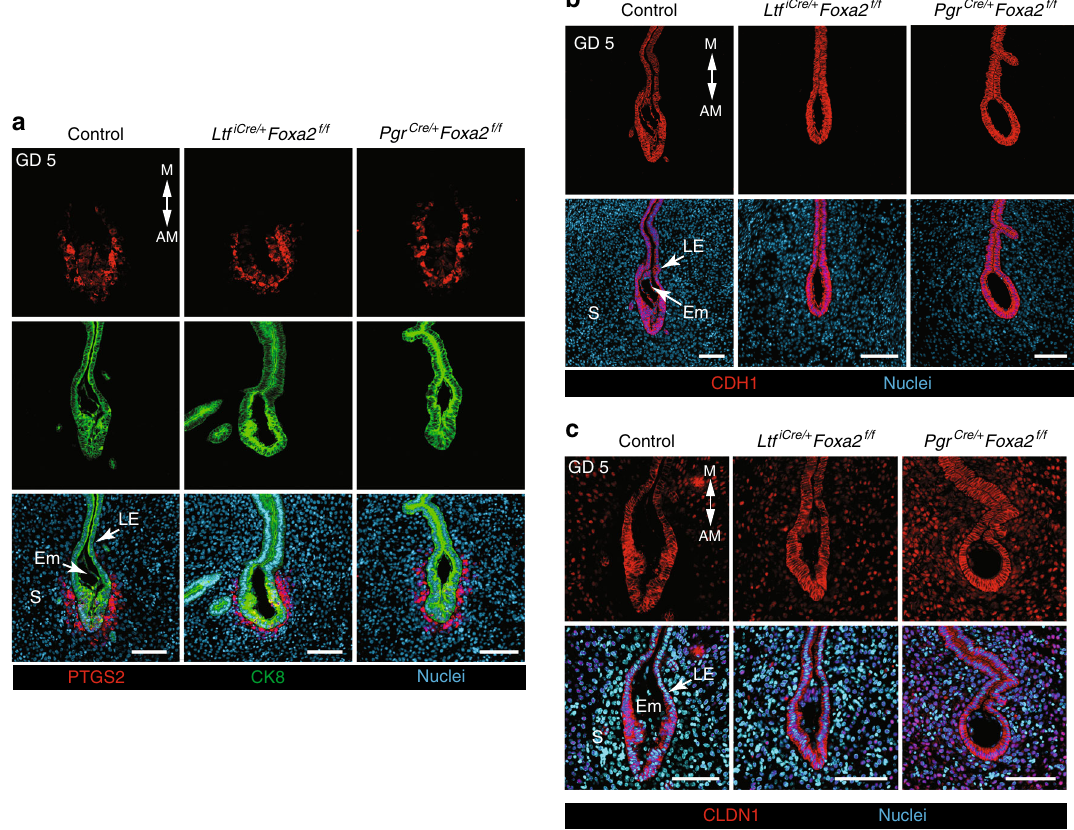
Fig. 3 Stromal cell decidualization and epithelial remodeling in LIF-replaced FOXA2-de fi cient mice. Control, gland-containing Ltf iCre/ + Foxa2 f/f and glandless Pgr Cre/ + Foxa2 f/f mice received i.p. injections of recombinant mouse LIF on GD 4 and were evaluated on GD 5 at 0800 hours. a Immuno fl uorescence analysis of PTGS2 and CK8 in implantation sites. PTGS2 is present in the stroma around the implanting embryo on the antimesometrial side of the uterus. Scale bar: 100 μ m. b Immuno fl uorescence analysis of CDH1 in implantation sites. Scale bar: 100 μ m. c Immuno fl uorescence analysis of CLDN1 in implantation sites. Scale bar: 100 μ m. AM: antimesometrial, M: mesometrial, Em: embryo, LE: luminal epithelium, S: stroma. All images are representative of three independent